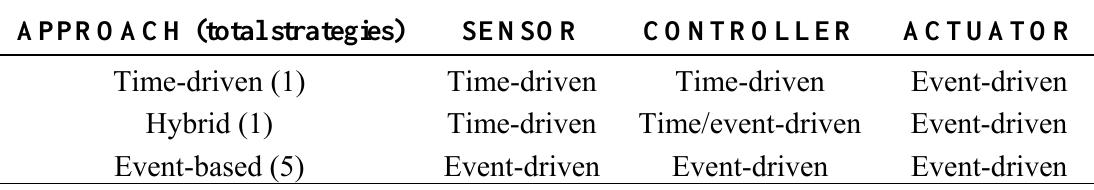
Table 2. Nature of the control agents in the three control